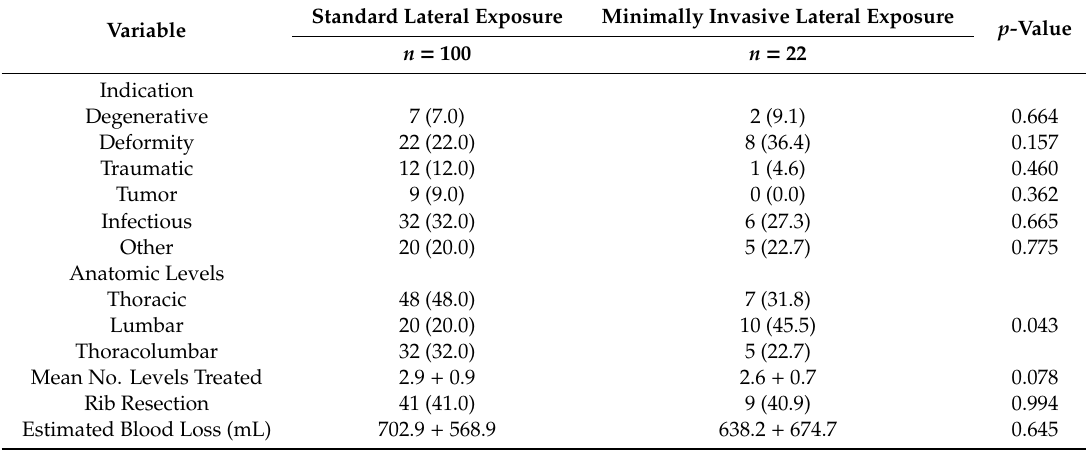
Table 2. Operative data †